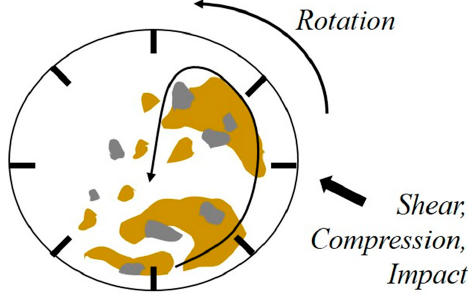
Figure 1. Principle of abrasion crusher.